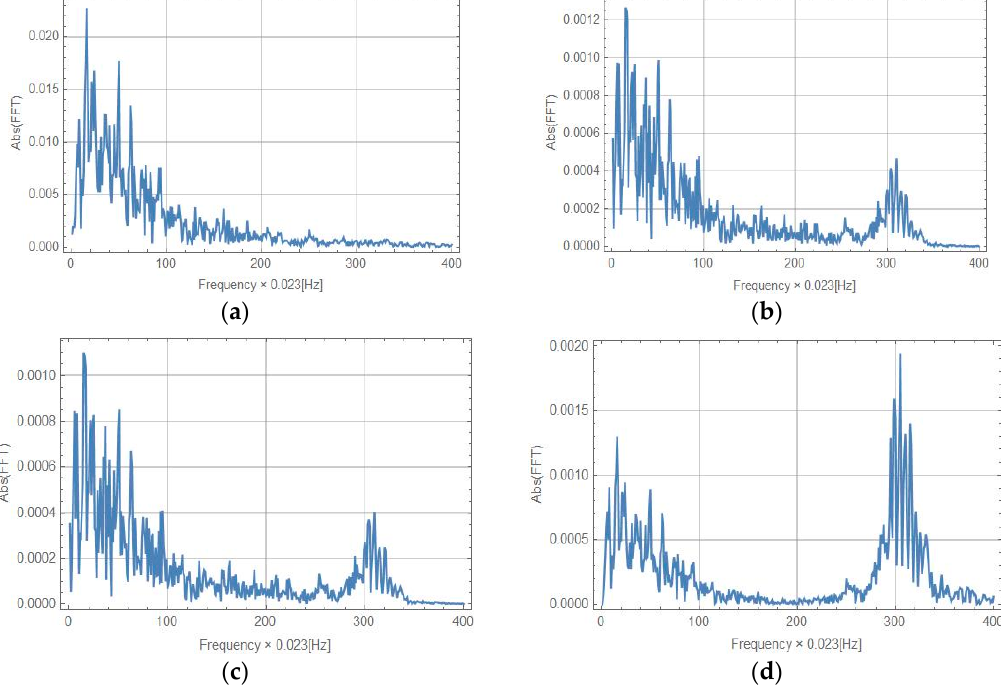
Figure 13. Spectrum characteristics for sweep sine excitation: ( a ) rotation from accelerometer PCB 333B52; ( b ) FOSREM-SS; ( c ) FOSREM-BB; ( d ) HZ1-100-100.